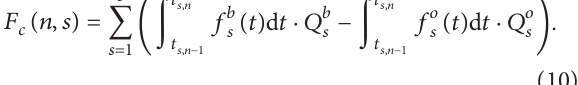
Table 3: Sets and variables of the problem